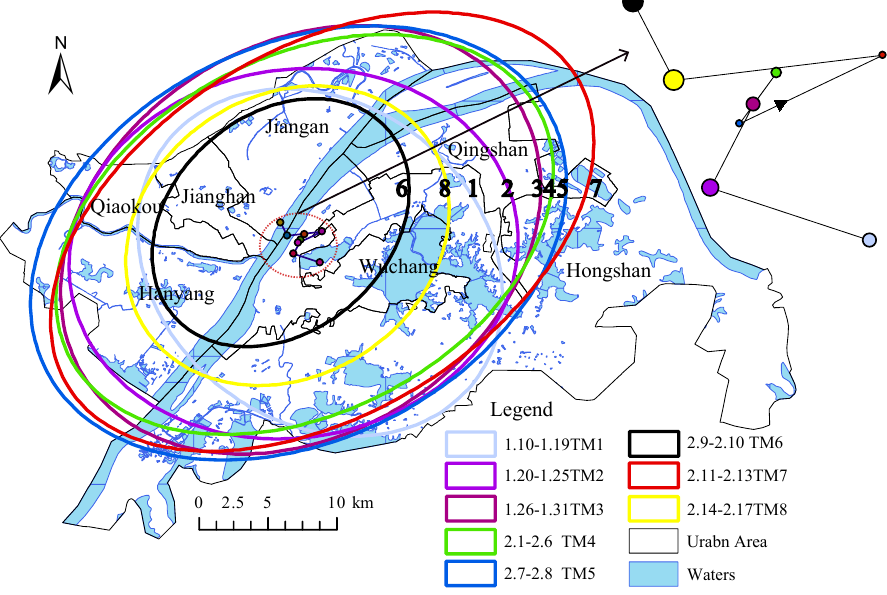
Figure 5. Weibo discussion direction distribution and focus